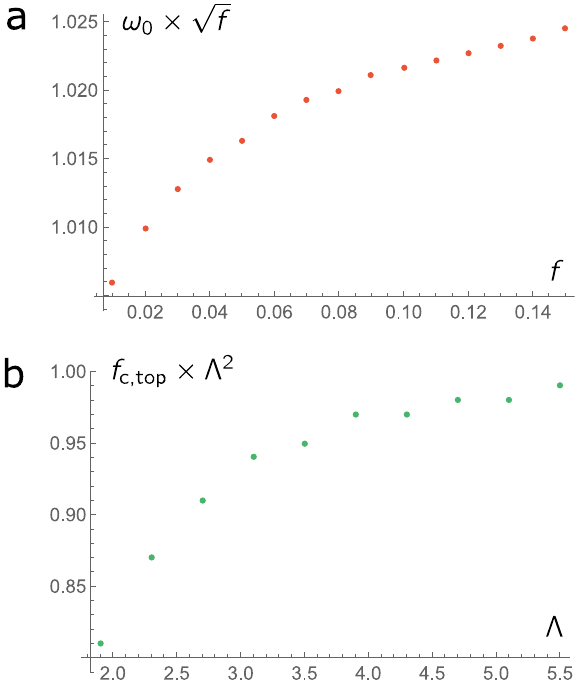
Fig. 2 Scaling behavior at the transition towards the nodeless superconductor. a Numerical check of Eq. (6) for small f . b Numerical check of Eq. (10) for moderate Λ . The apparent oscillations are due to discretization of f in the numerics. Used parameter: λ =